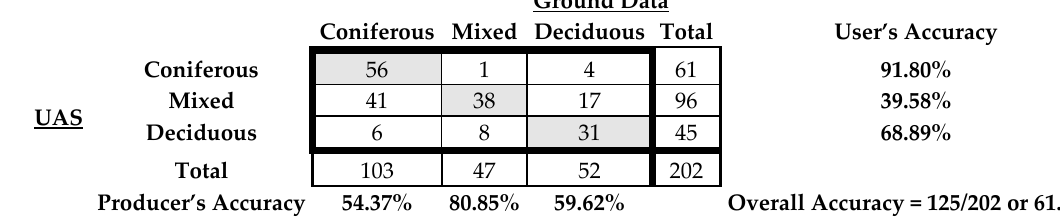
Table 8. UAS forest stand thematic map error matrix for CFI plot-registered samples. Ground (reference) data are represented by the CFI plots and Unmanned Aerial Systems (UAS) data are derived from the corresponding orthomosaic.